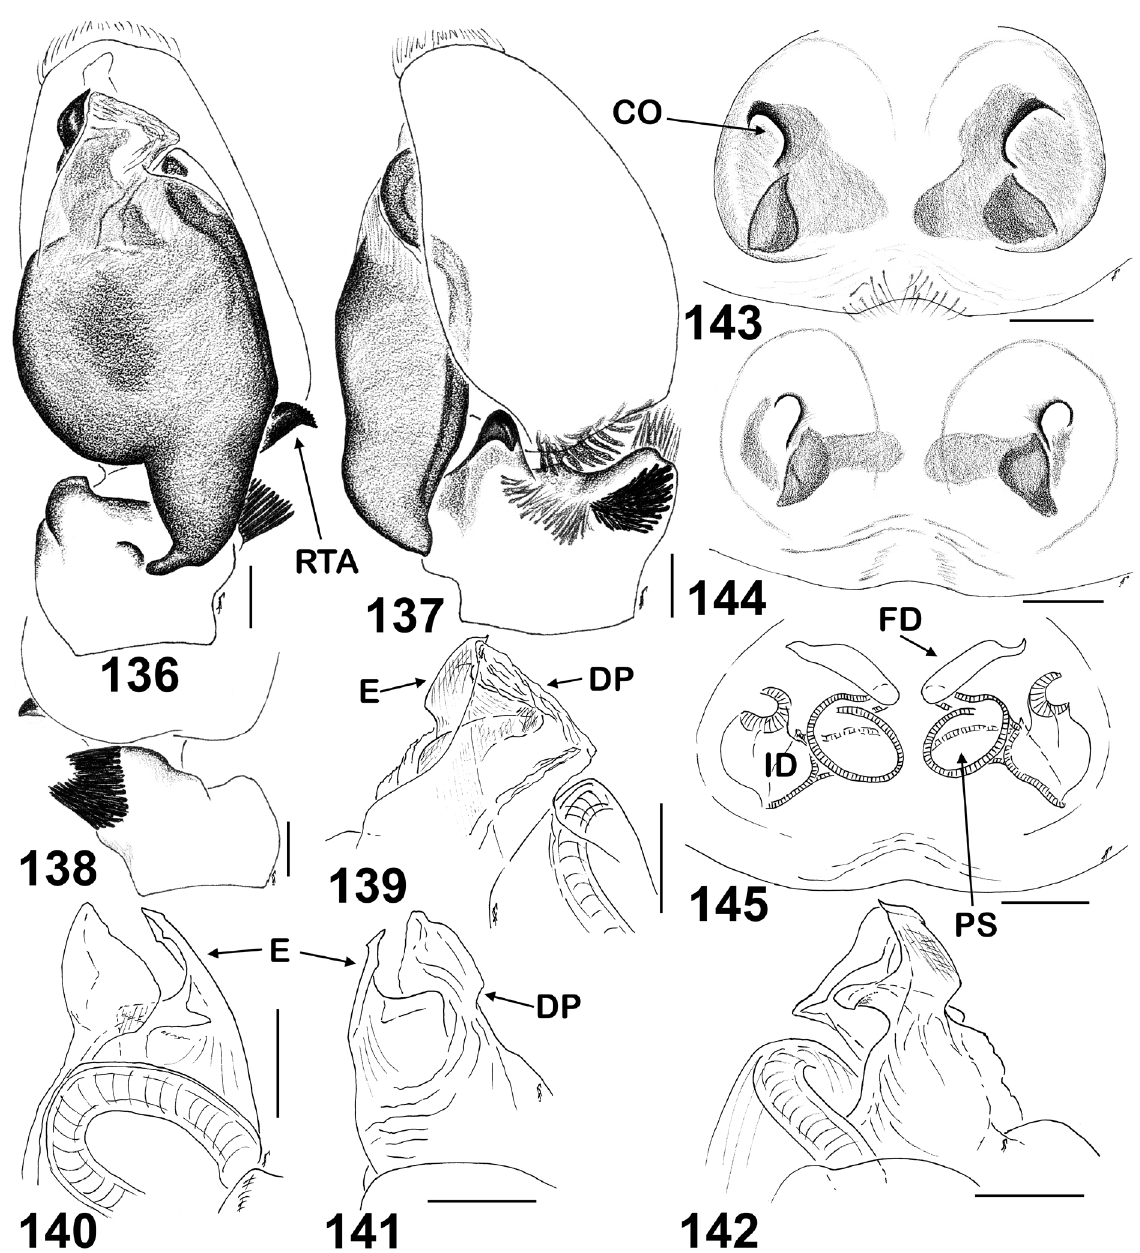
Figs 136–145. Stenaelurillus fuscatus Wesołowska & Russell-Smith, 2000, ♂ (136–142), and ♀ from Kenya (Taita Discovery Centre; MRAC 213.133) (143–145). 136 . Male palp, ventral view. 137 . Male palp, retrolateral view. 138 . DTA, dorsal view. 139–142 . Embolic division. 139 . Ventral view. 140 . Retrolateral view. 141 . Median view. 142 . Dorsal view. 143–144 . Epigyne, ventral view. 145 . Spermathecae, dorsal view. Scale bars: 0.1 mm. Abbreviations: see Material and